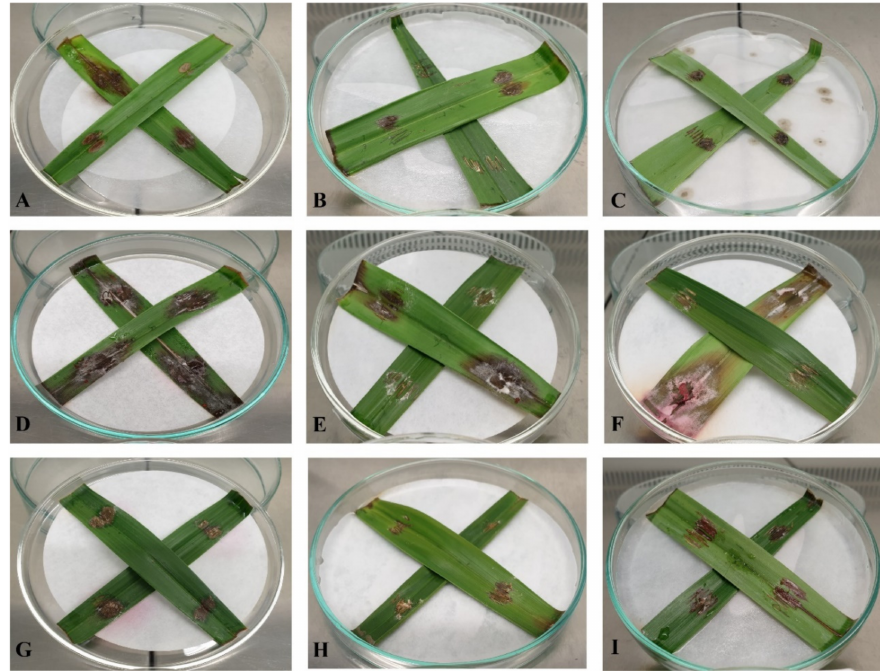
Figure 2. Pathogenic results of detached leaf assays in leaflets of date palm inoculated with ( A ) Alternaria destruens SQU-LSS1b, ( B ) Cladosporium endophyticum SQU-EIQQ1, ( C ) Cladosporium pseu- dochalastosporoides SQU-LIQ4, ( D ) Fusarium fujikuroi species complex SQU-LIS1, ( E ) Fusarium humuli SQU-LSFM3c, ( F ) Fusarium microconidium SQU-LSS2b, ( G ) Phaeoacremonium krajdenii SQU-LMA4b, ( H ) Phaeoacremonium venezuelense SQU-LAH3, and ( I ) Quambalaria cyanescens